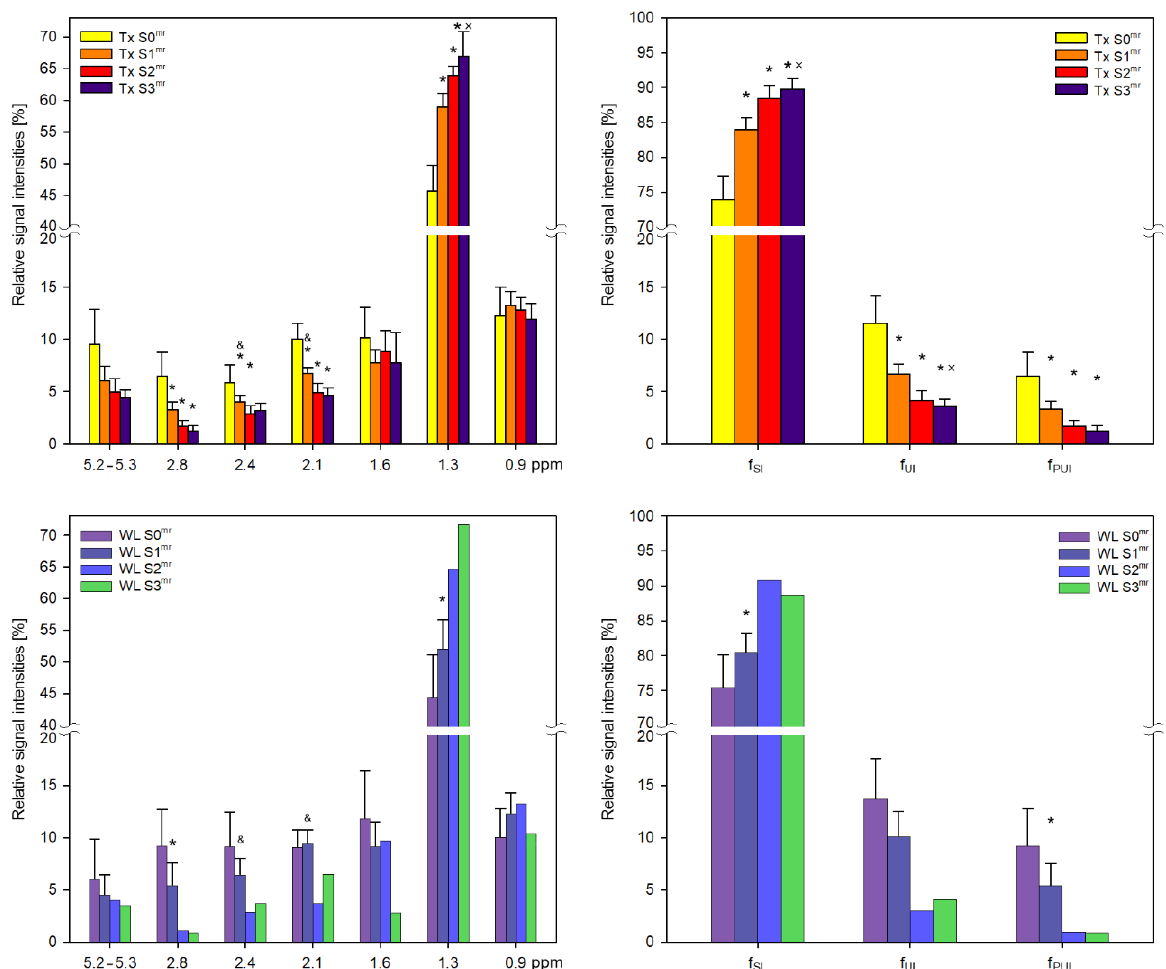
Figure 3. MR metabolic profiles of lipids in liver transplant recipient (Tx) and LT candidate (WL) groups with respect to steatosis grade. Relative signal intensities (in [%]) together with 95% intervals of confidence of liver fatty acids within chemical shift ranges of 0–3 ppm and 5.2–5.3 ppm were obtained from spectra with water suppression in Tx and WL groups. Fractions of hydrogen atoms [%] in saturated (f SI ), unsaturated (f UI ) and polyunsaturated (f PUI ) fatty acid chains are also demonstrated. With regard to S2 and S3 WL cases, only data for one subject are shown for comparison purposes. * significant difference from S0 mr ; × significant difference from S1 mr ; & significant difference between Tx and WL groups.